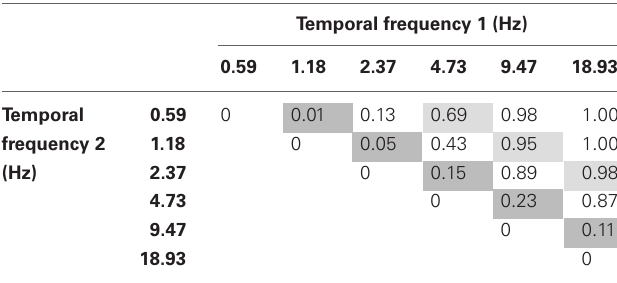
Table 1 | Proportion of trials yielding a perception of binocular rivalry for various temporal frequency